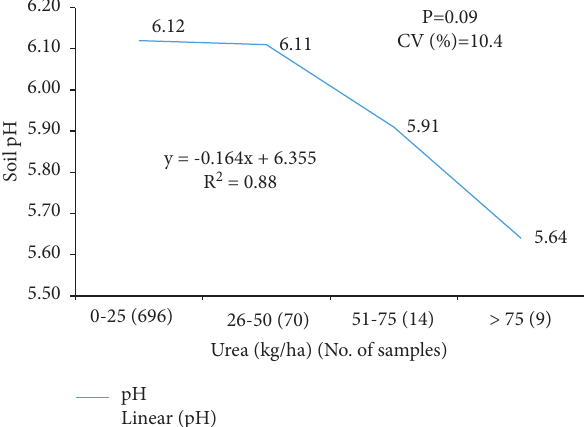
Figure 2: pH level on crop fields with different rates of DAP fertilizer.